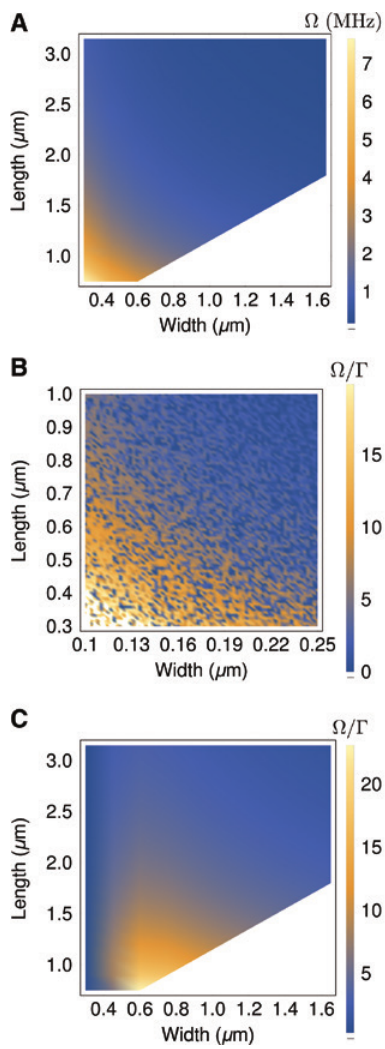
Figure 3: Dimensional dependence of optical properties within (100) aligned diamond nanowires. (A) Density plot of the photoionization frequency Ω as a function of wire dimension. (B) Density plot of the ratio of the photoionization frequency to the optical decoherence rate ( Ω / Γ ) as a function of dimension for a surface confined nanowire. (C) Density plot of the ratio of the photoionization frequency to the optical decoherence rate ( Ω / Γ ) as a function of nanowire dimension for an electrostatically confined nanowire. Note that we have omitted calculations of Ω and Ω / Γ for wires with w > L